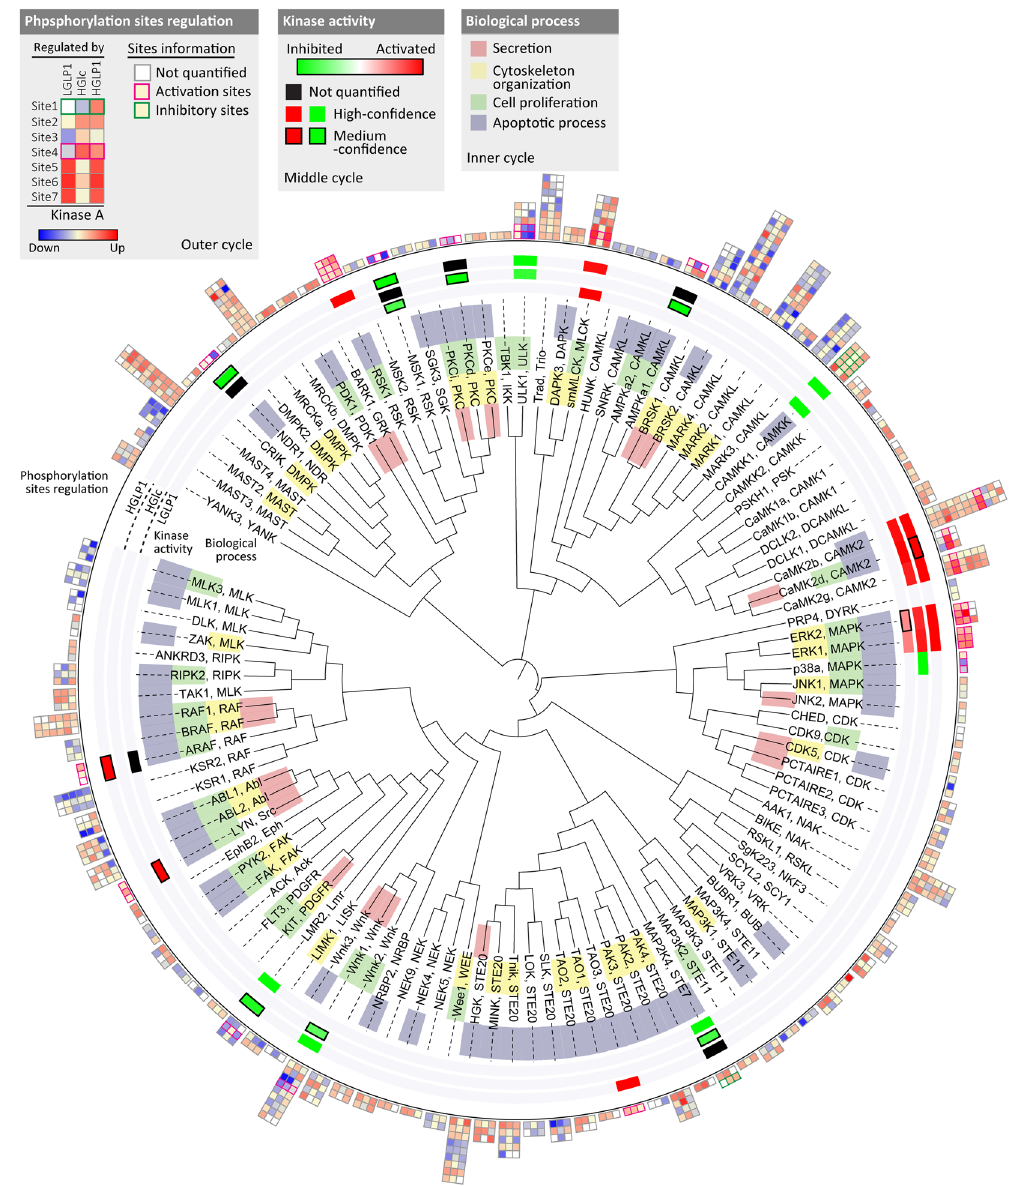
Figure 6. β -cell kinome regulated by GLP-1 and glucose. Regulated kinases were ordered by phylogenetic distance of the kinase domain retrieved from KinBase (mouse ortholog), and displayed using iTOL (see Methods for details). The phosphorylation change of each regulated sites on each kinase induced by different treatments were presented using heatmap in the outer rim. In the middle rim, the activation or inhibition status of regulated kinases were determined by the direction and amplitude of change of reported activation or inhibitory sites. The biological process that these kinases involved in were annotated according to GO database, and displayed in the inner rim. All proteins were listed by their corresponding gene names used by